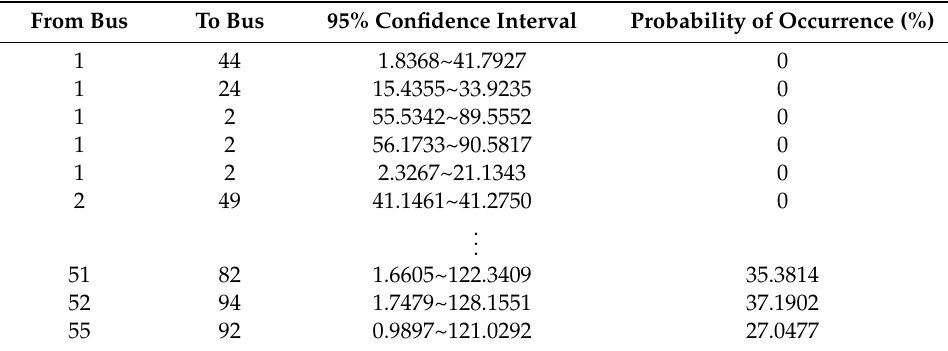
Table 9. Power flow data for post N-1 contingency; transmission line load (%).